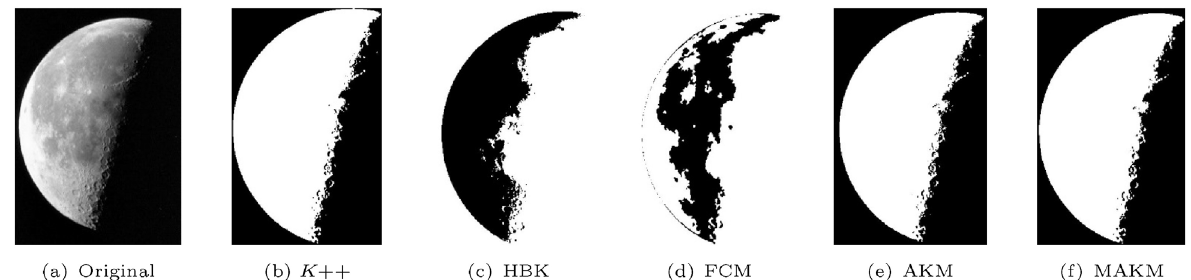
Fig. 6 Moon-labeled image segmented using various